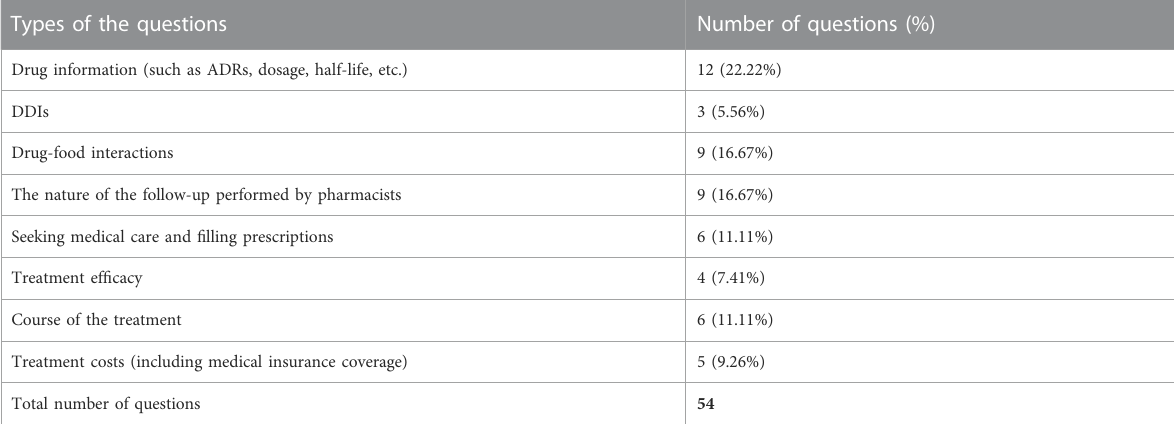
TABLE 7 Questions from patients during the follow-up